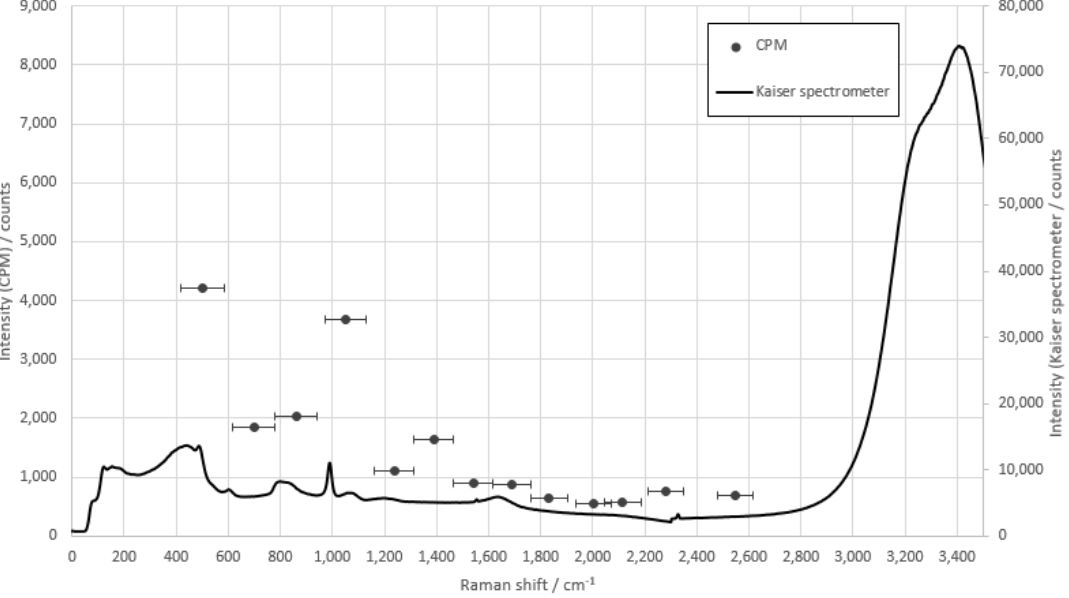
Figure 7. Comparison measurement of di-sodium hydrogen phosphate with the fiber array compared to the raw spectra of the Kaiser spectrometer. The integration time of the CPMS is 1 s, and the integration time of the Kaiser spectrometer is 10 s.